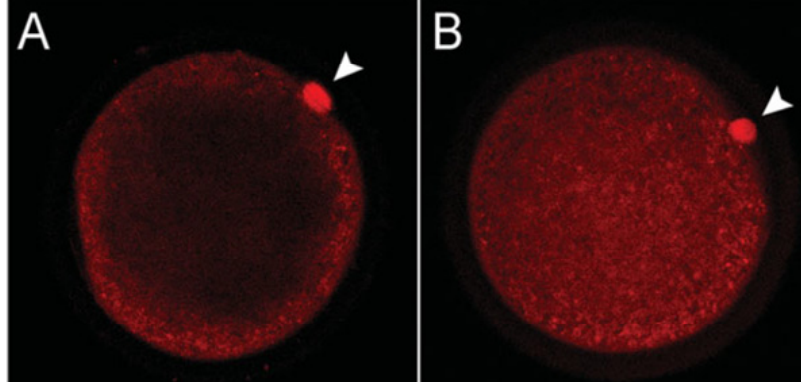
Figure 7. Distribution of mitochondria (identified with Mito Tracker ® Red) in MII bovine oocytes matured in the absence ( A ) or presence ( B ) of melatonin in the culture medium. The medium was supplemental with melatonin at a concentration of 10 ng/mL. The subcellular distribution of the mitochondria was markedly impacted by the presence of melatonin, probably due to the actions of the indoleamine or the cytoskeleton. In the control cells, the mitochondria were clustered around the periphery of the ovum whereas melatonin treatment caused their dispersion throughout the cell. The arrowheads identify the first polar body. From El-Raey et al. [97] with